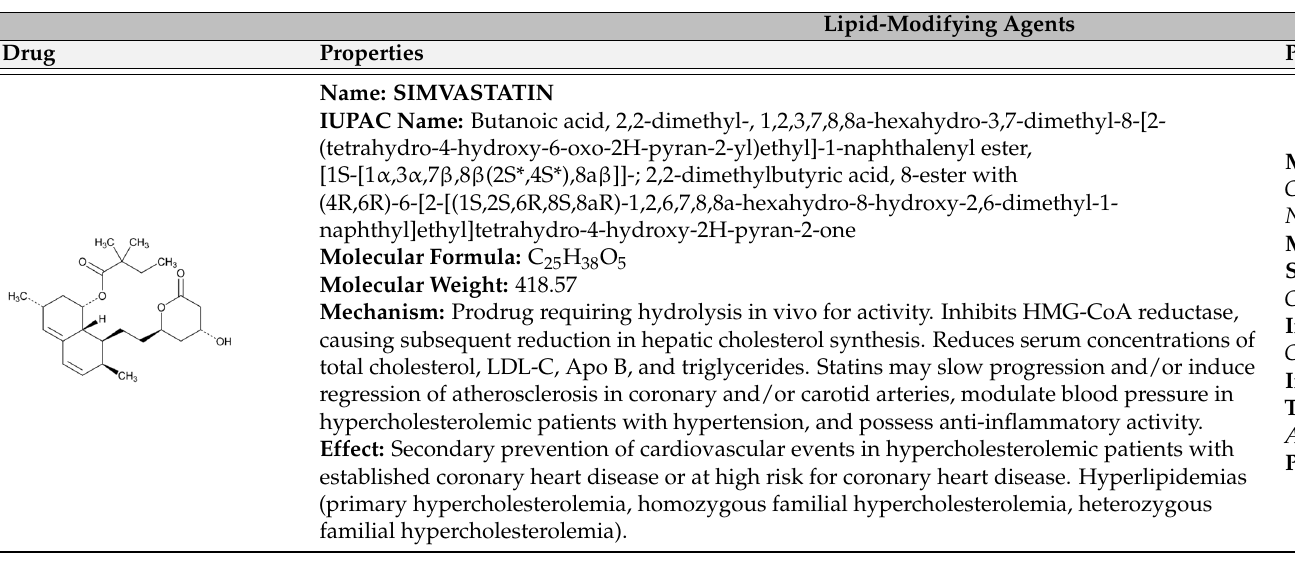
Table 3. Pharmacogenomics of antithrombotic drugs.